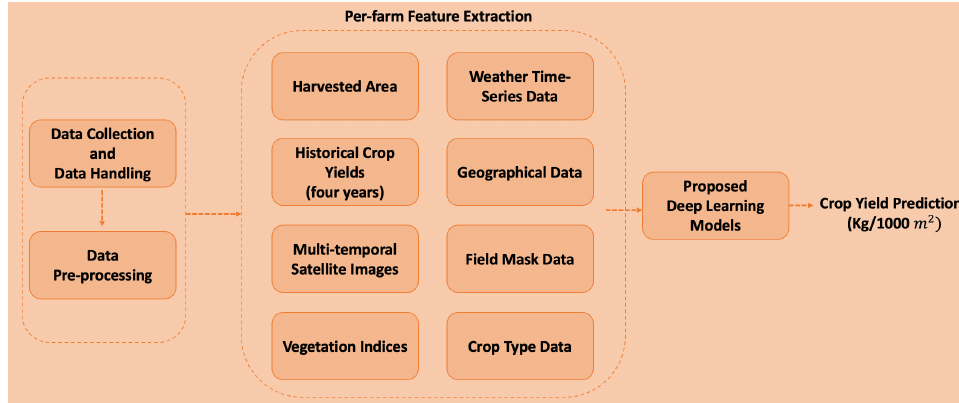
Figure 1. Research methodology for this research